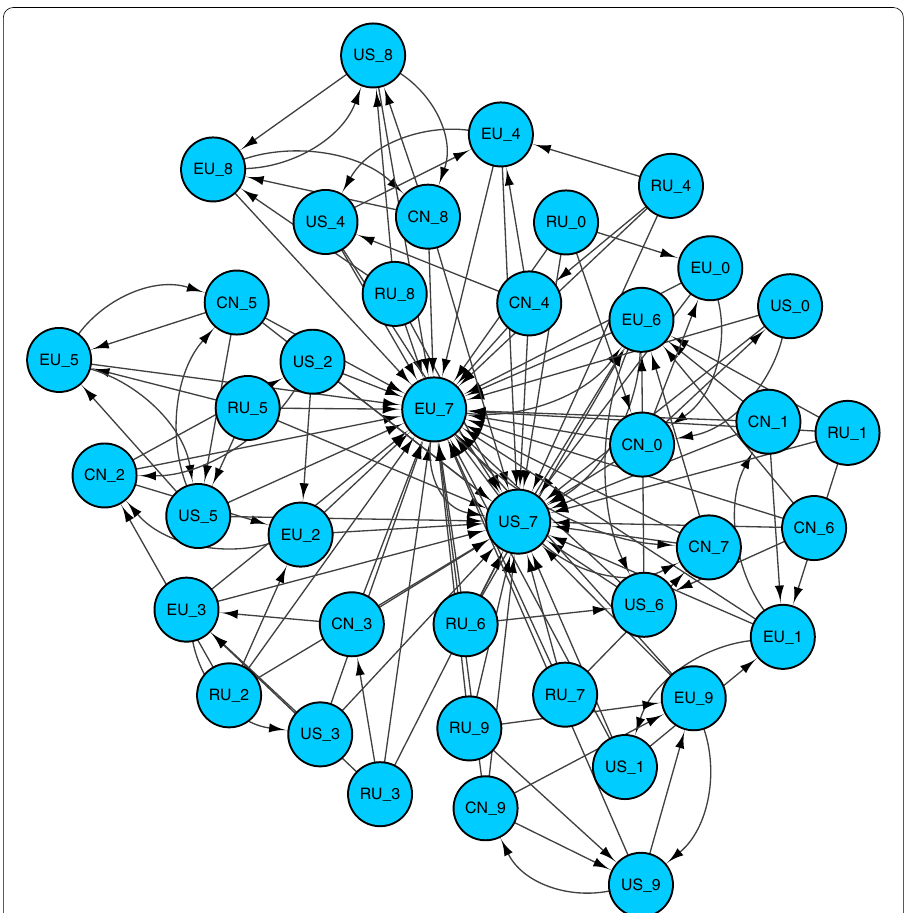
Fig. 8 Network trade structure. Network trade structure between KEU9 (marked as EU), USA (US), China (CN), Russia (RU) with 10 products of Table 1 in year 2018. Network is obtained from the reduced Google matrix G R by tracing four strongest outgoing links. Countries are shown by circles with two letters of country and product index from Table 1. The arrow direction from node A to node B means that B imports from A . All 40 nodes are